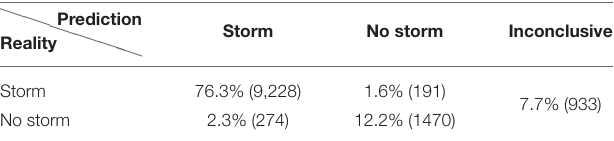
TABLE 3 | Experiment 1: FNN 1 using B x only.